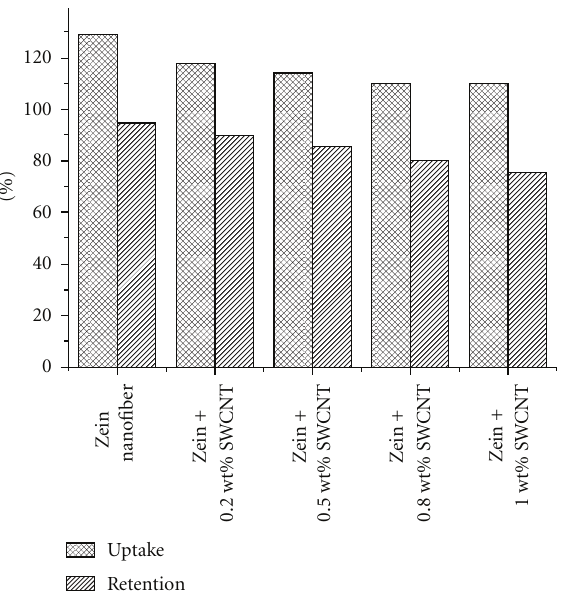
Figure 5: Water uptakes and water retention ability of zein sca ff old, and Zein-SWCNT sca ff olds after 24 hr. ( n =